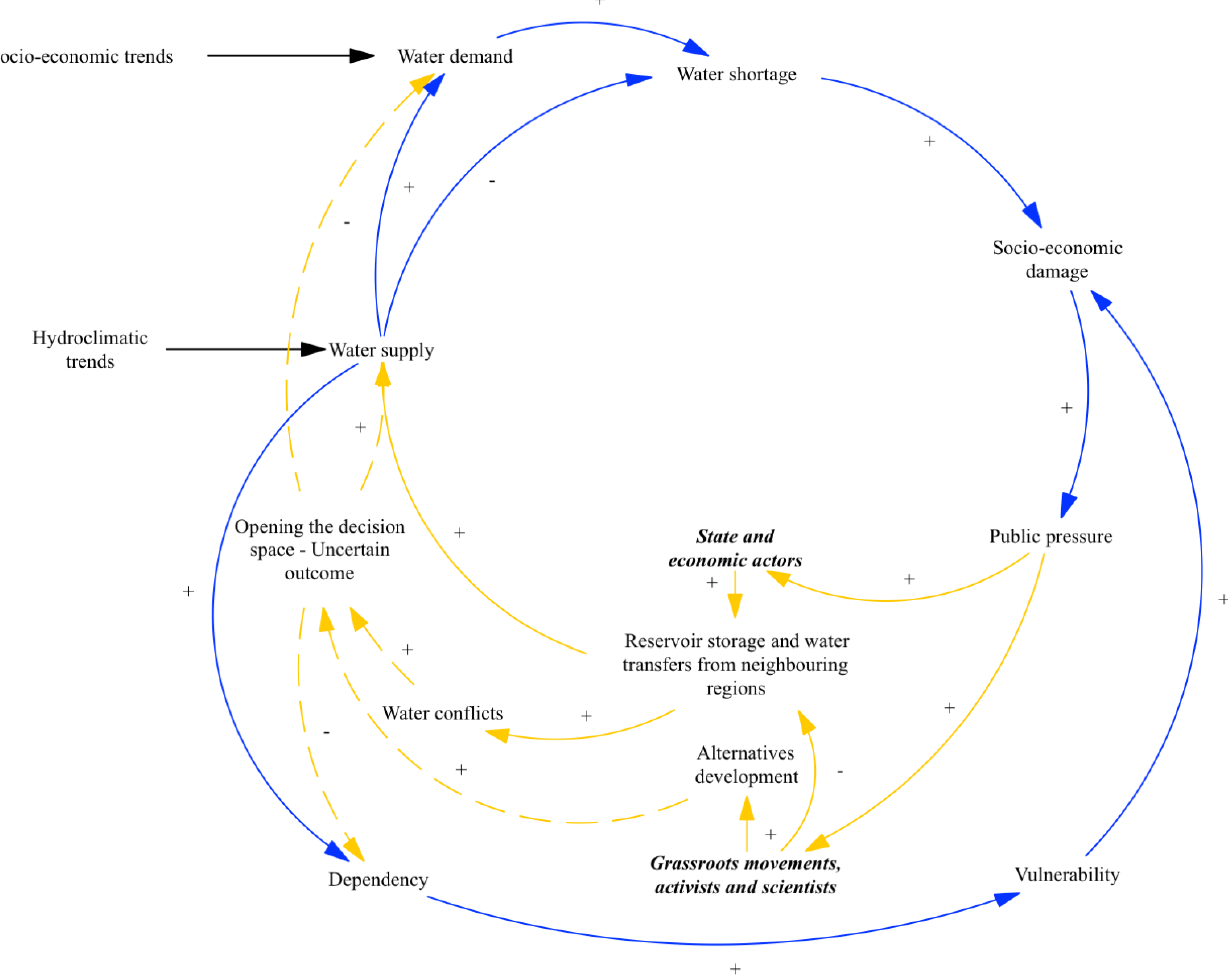
Figure 4. The water conflict disruption in the reservoir effect (the dashed lines indicate their hypothetical status, while the pink lines indicate new variables not yet considered by the original conceptualization by Di Baldassarre et al.,